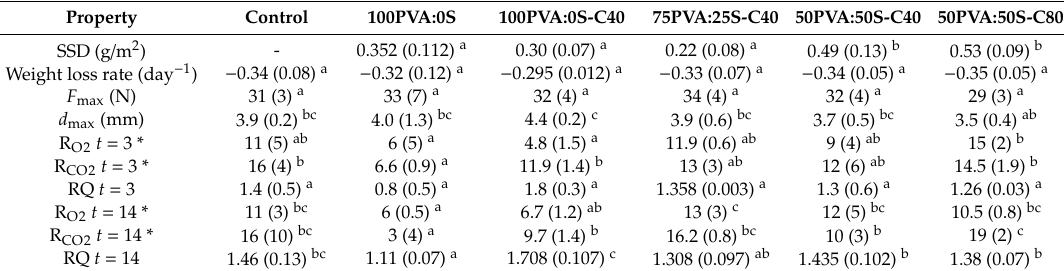
Table 2. Surface solids density (SSD), weight loss rate, force and distance at the failure point (Fmax, dmax), O 2 consumption rate and CO 2 production rate, and respiration quotient (RQ) of coated and uncoated (control)